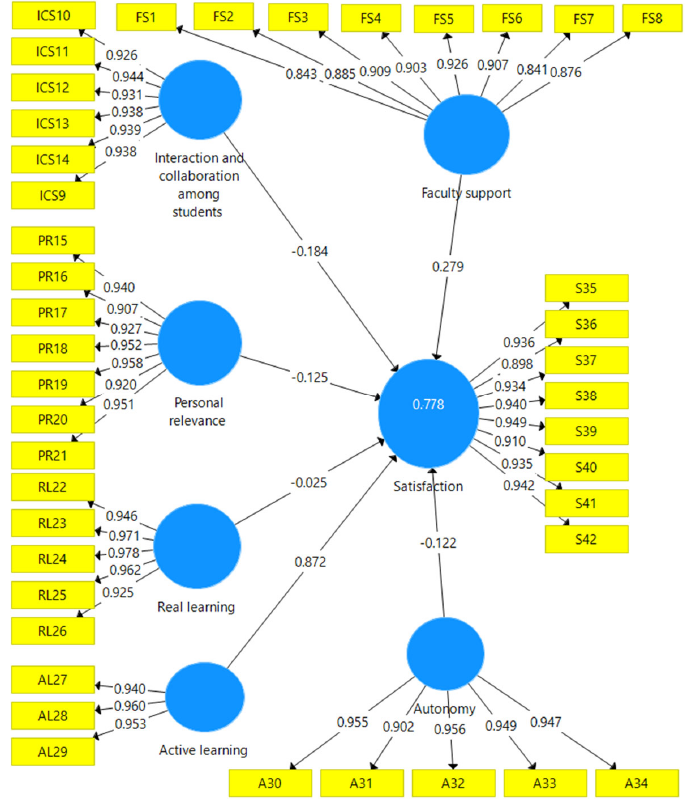
Fig. 4. Measurement model